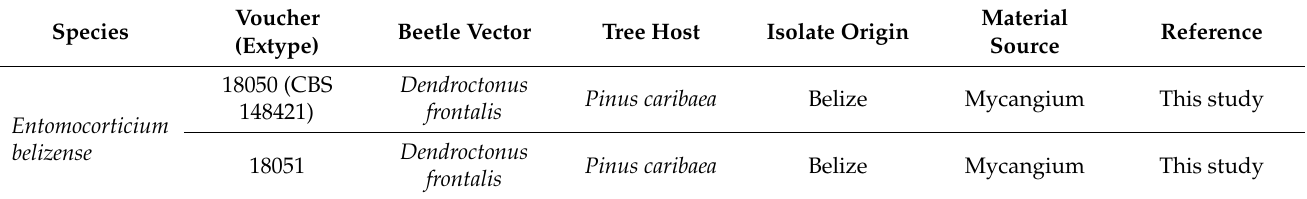
Table 1. List of isolates obtained in this study and other Entomocorticium isolates included in the analyses.